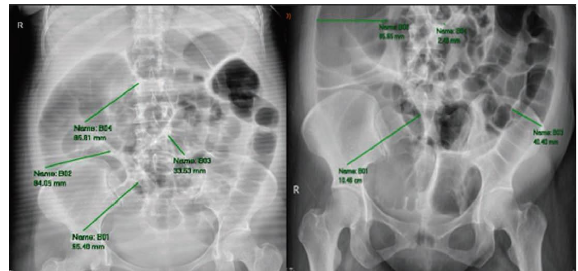
Figure 1: Serial scout flm of the abdomen. Description: regression of ileus; there is a decrease in number and amount of air-flled small bowel segments with no organizing pattern.